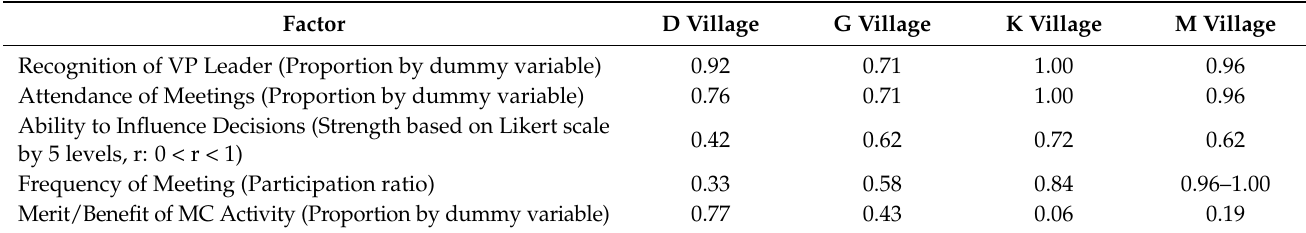
Table 4. Indicators of people’s participation (by